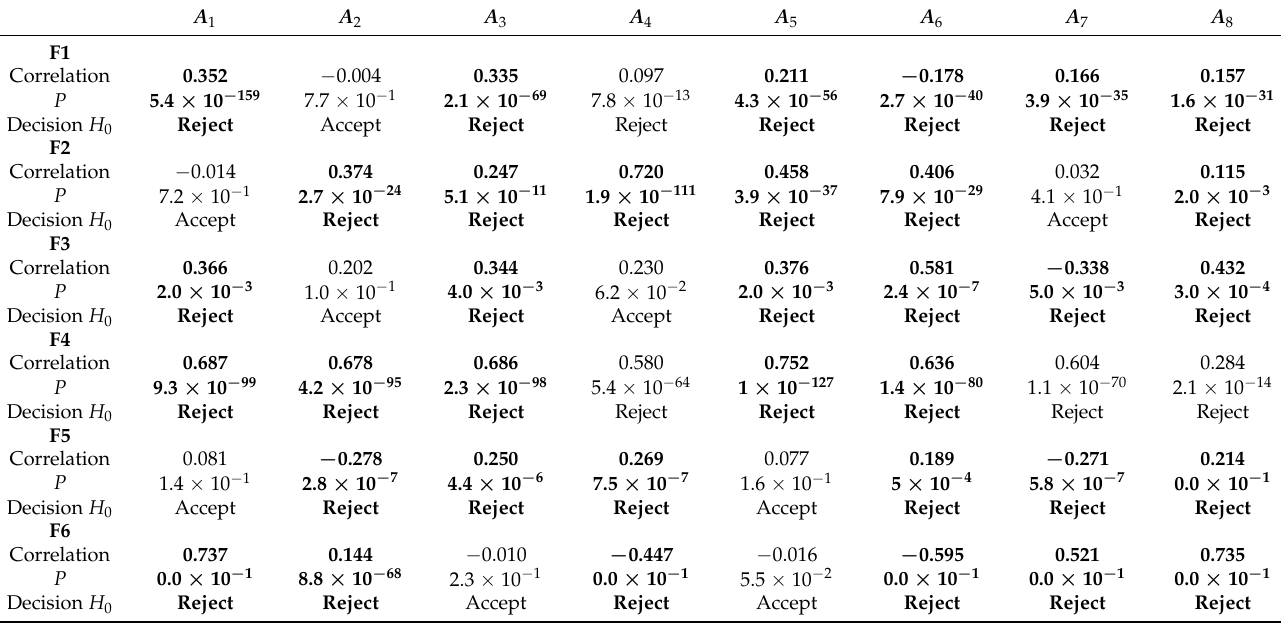
Table 6. Correlation analysis ( ρ ) for 8 sampled attributes for F1–F6.